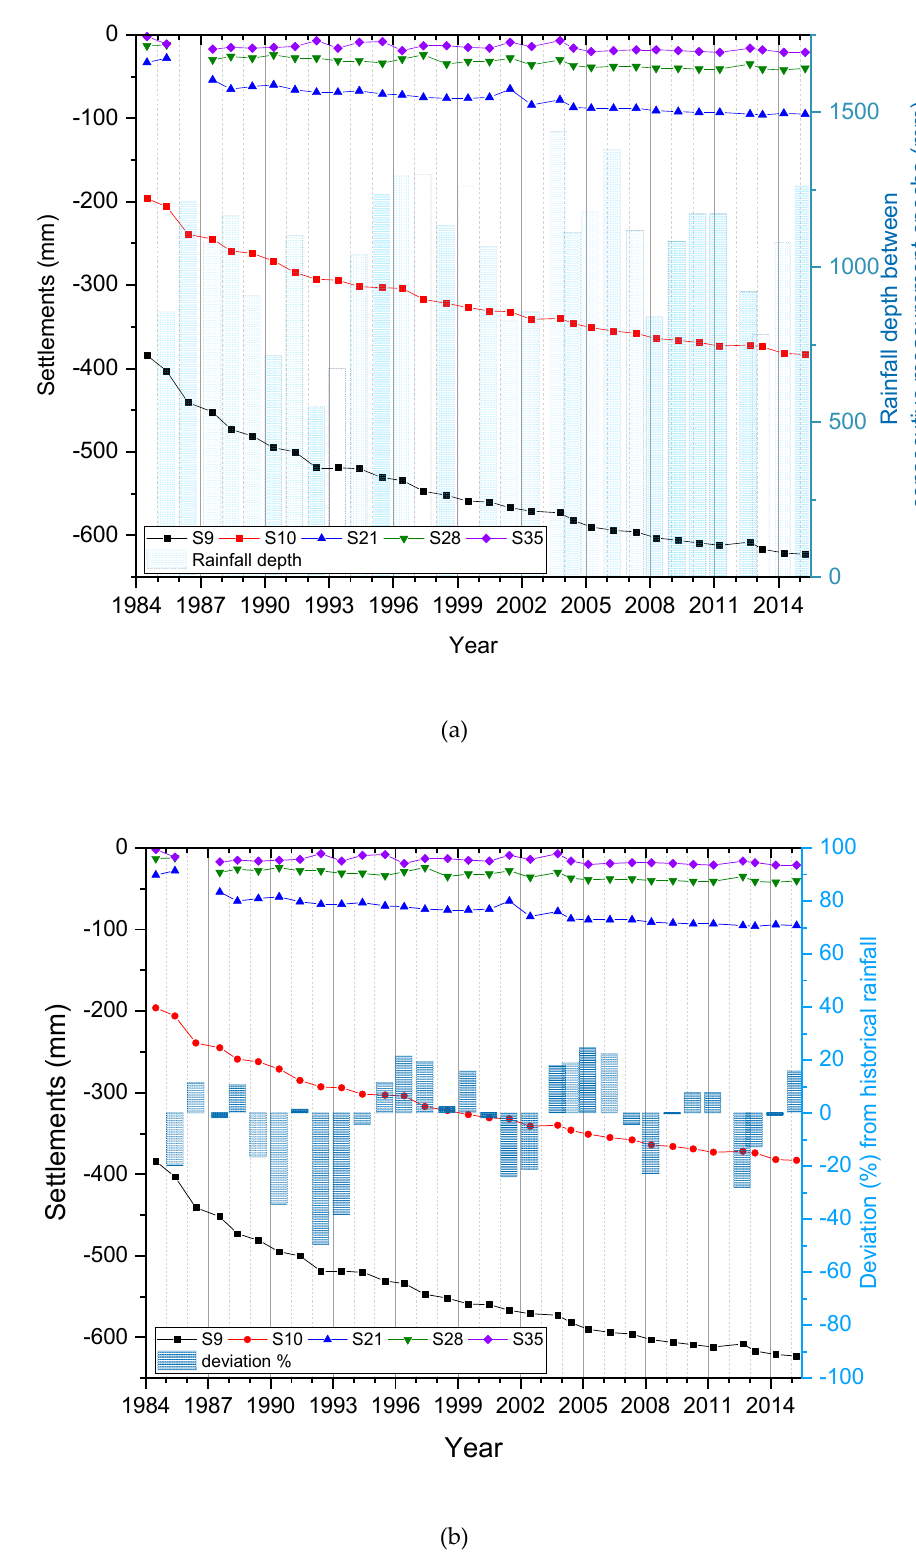
Figure 8. Settlements across A-A section and ( a ) rainfall depth between consecutive measurement epochs, and ( b ) deviation (%) of rainfall depths between consecutive measurement epochs from historical rainfall